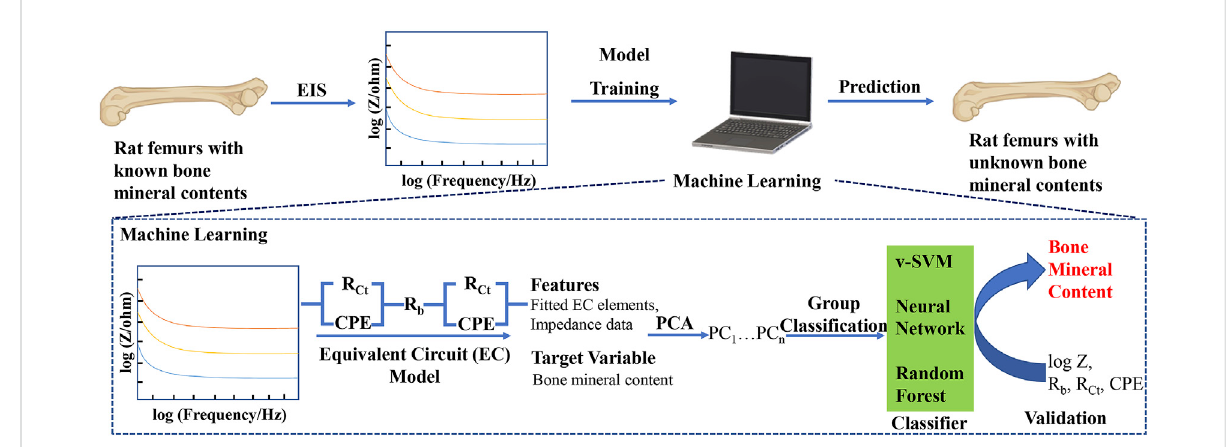
FIGURE 1 Schematic of machine learning-assisted electrochemical impedance spectroscopy (EIS) for the quantitative analysis of bone mineral content. PCA: Principal Component Analysis; v-SVM: Support Vector